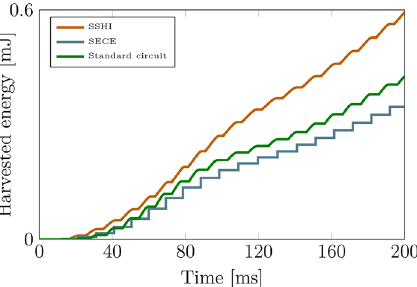
Fig. 16 Harvested energy E of the bimorph PVEH with load adap- tion standard, load adaption SSHI circuit, and SECE circuit under a harmonic base acceleration of 9.81 m/s 2 and a frequency of 48.7